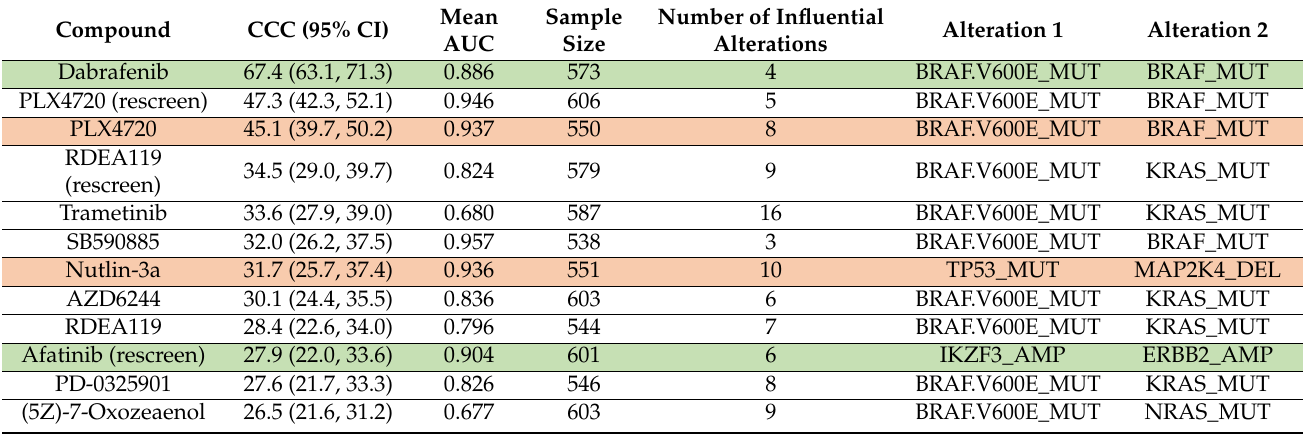
Table 2. Report 1 up to the two most influential alterations for each compound (in decreasing order of CCC).